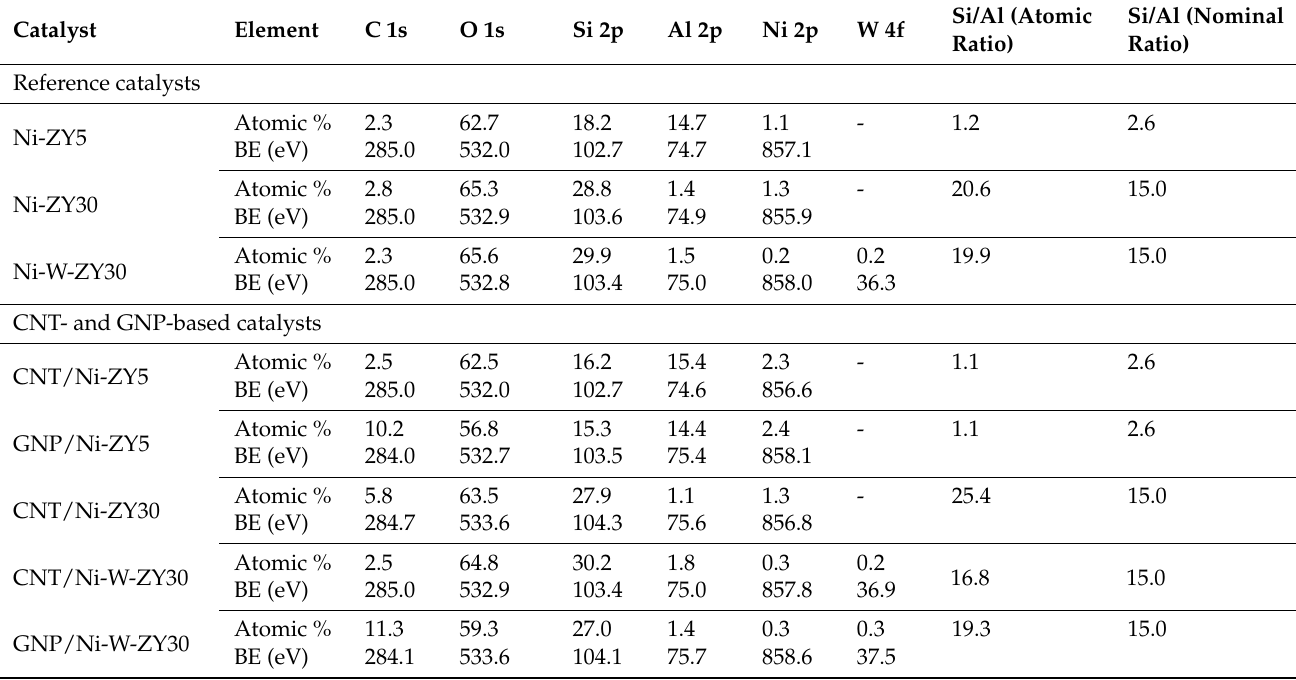
Table 2. Elemental compositions and binding energies (BE) of CNT/Ni-ZY5, GNP/Ni-ZY5, CNT/Ni- Ni-ZY30, and Ni-W-ZY30, as determined via